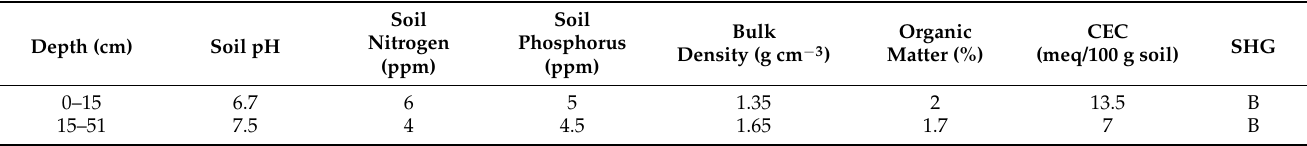
Table 1. Soil Characteristics of the study site, Brookings,